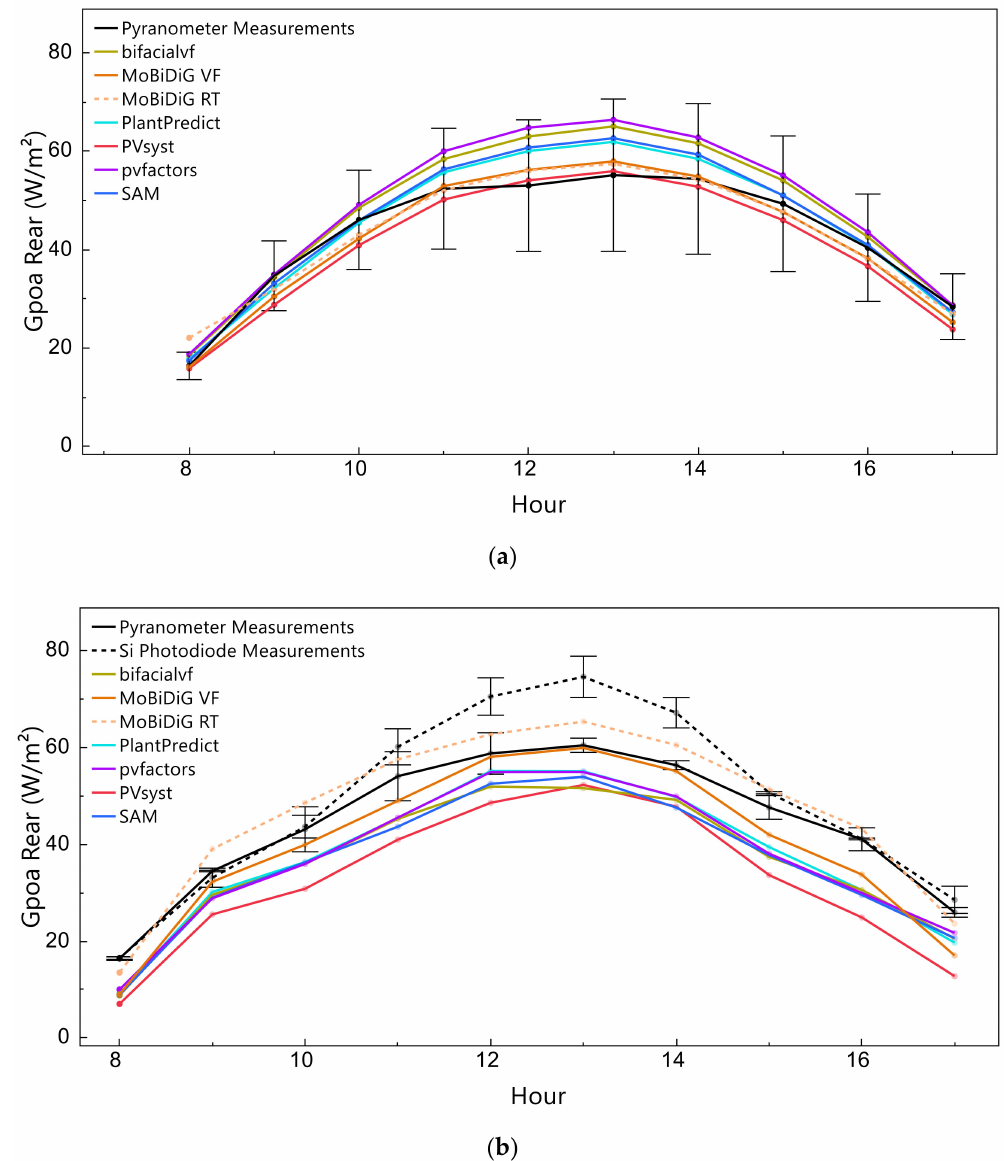
Figure 7. Timeseries plots of modeled and measured rear plane of array irradiance ( G POA,Rear ) on a cloudless day (23 March 2020). The error bars around the measured values show the maximum and minimum measurements made by two sensors. ( a ) Fixed-tilt system where rear-facing POA pyranometer measurements are made 17 m from the western array edge. ( b ) HSAT system where rear-facing silicon photodiode and pyranometer measurements are made 12 m from the southern array